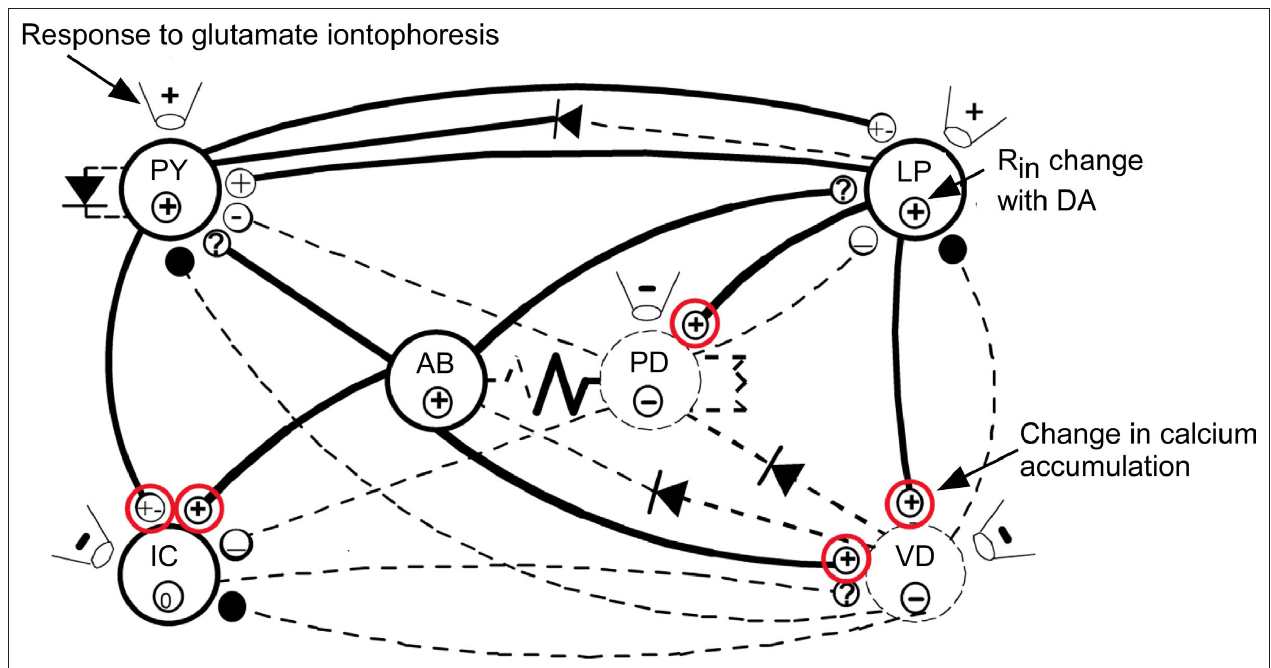
to glutamate iontophoresis shown in the pipette symbols next to each neuron. Known DA effects on transmitter release and Ca 2 + accumulation are shown in the terminal symbol for synapses (modified from Harris-Warrick et al., 1998). Red circles indicate synapses with opposing pre- and post-synaptic actions of